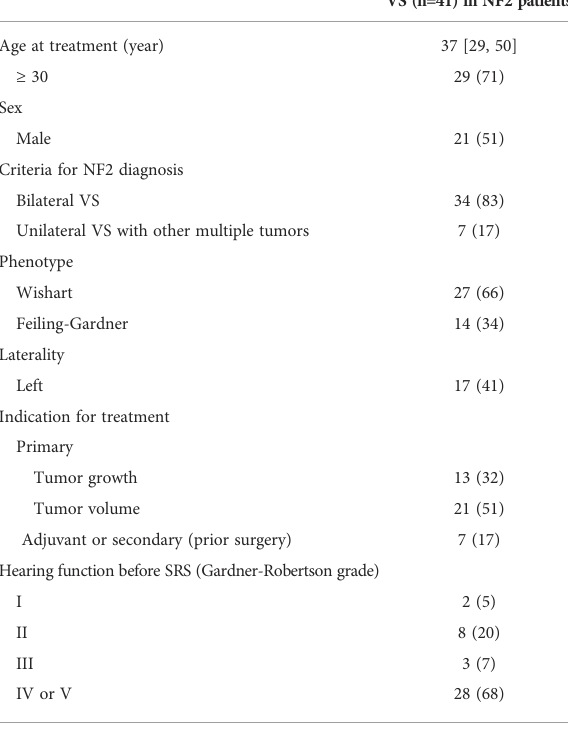
TABLE 1 Baseline characteristics of the study patients.